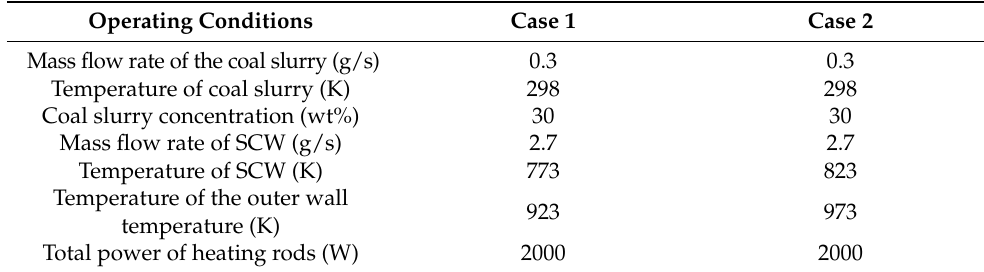
Table 3. Operating conditions for the SCWFB